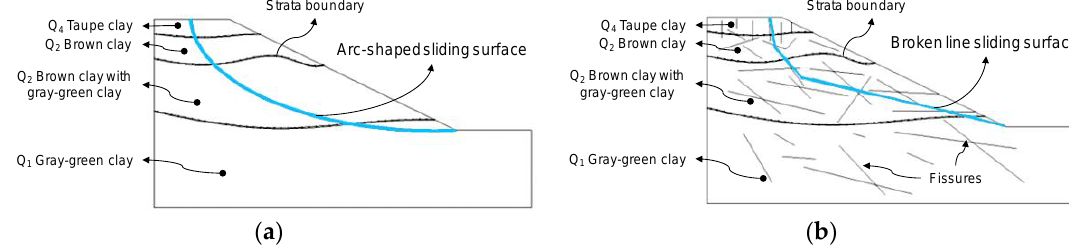
Figure 1. Conventional generalized sliding model and actual sliding model of expansive soil slope. ( a ) Arc-shaped sliding surface; ( b ) broken line sliding surface.